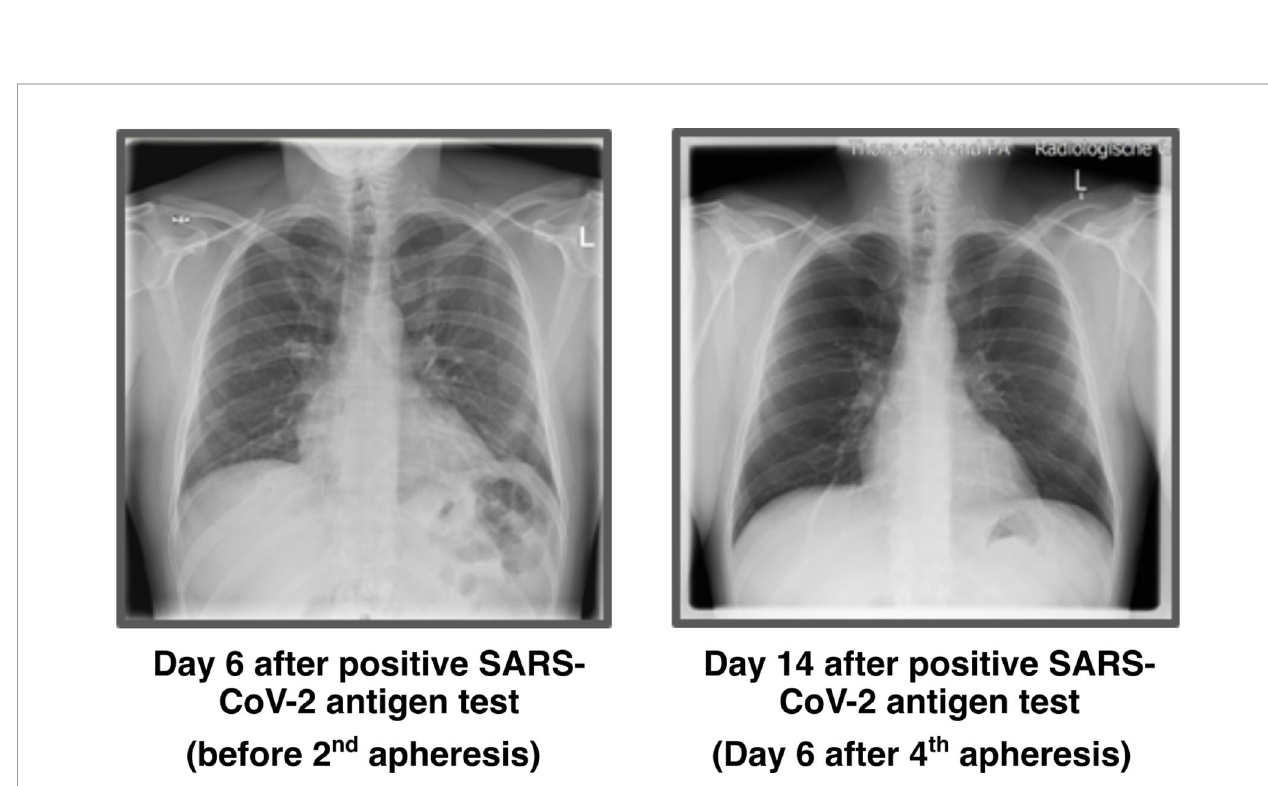
FIGURE 2 | Chest X-ray images. X-ray thorax in 2 planes left adjacent. 6 days: Streaky compressions of the lung in the lower fi eld/retrocardial left side. A low- grade concomitant effusion on the left. Heart normal size, no congestion. Upper mediastinum slender. No pneumothorax. Bony thorax intact. 14 days: No compressions and effusions.